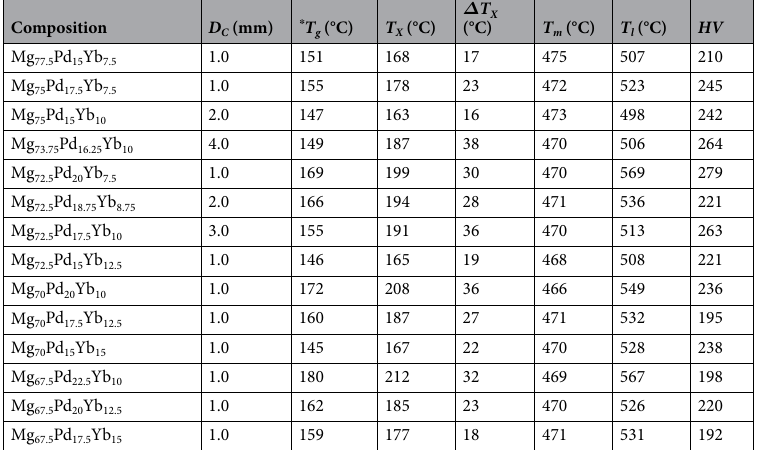
Table 4. BMG-forming compositions in the Mg-rich region of the Mg–Pd–Yb ternary system, and their associated critical casting sizes, thermophysical properties, and Vickers hardness. * T g values quoted here are the onset temperatures of the glass transition.